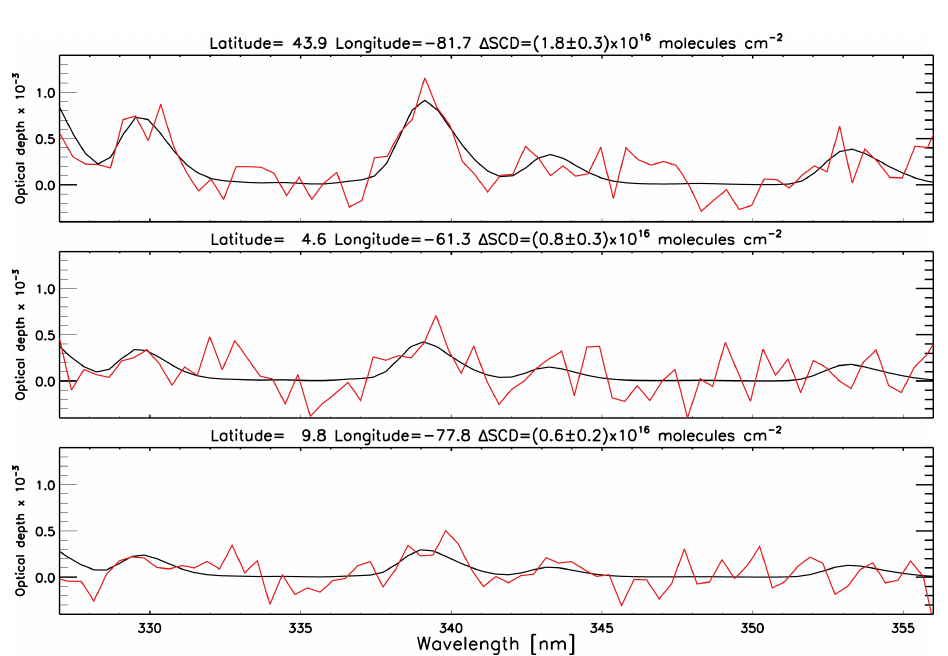
Figure 2. Fitting results of three pixels with decreasing concentrations of H 2 CO in orbit 3538 outside the SAA. Black lines represent the fitted H 2 CO optical depth, and red lines the fitted H 2 CO optical depth plus the fitting